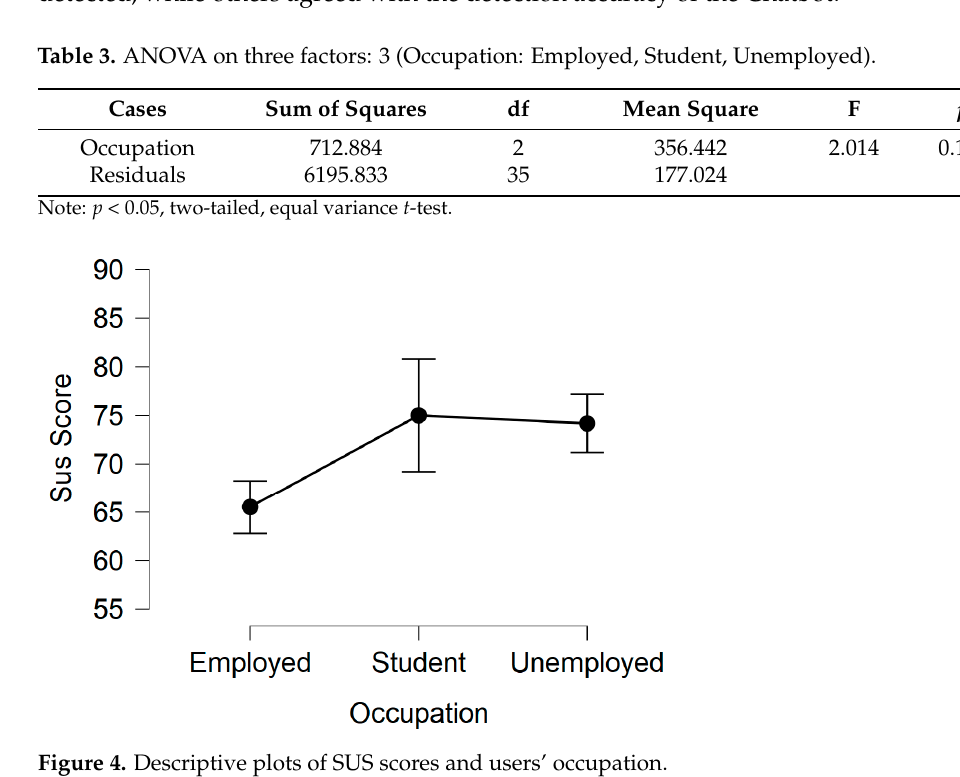
Figure 4. Descriptive plots of SUS scores and users’ occupation.